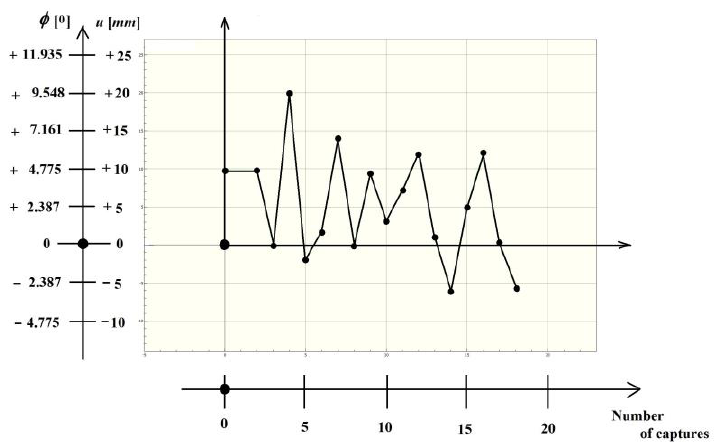
Figure 17. Diagram of variation of the linear displacement u 0 corresponding to the representative point P 0 and of the corresponding torsion angle Φ , for the case of the solitary operation of the left engine.